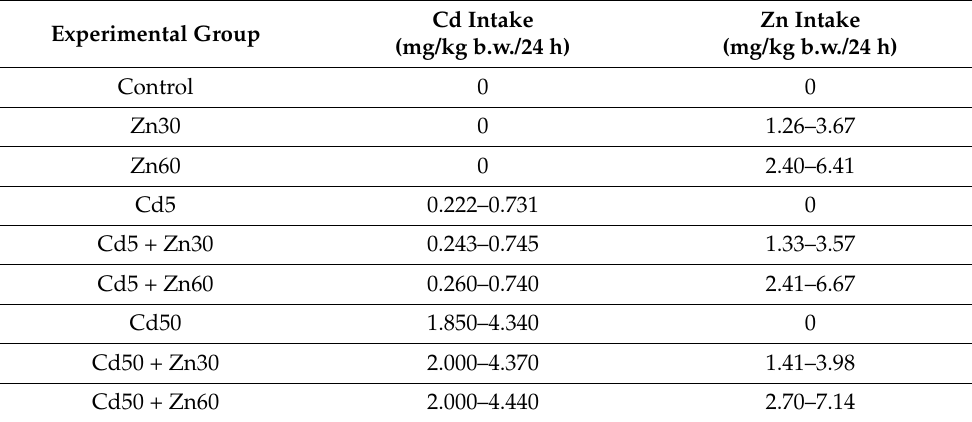
Table 1. The daily intakes of Cd and Zn in particular experimental groups [7] 1